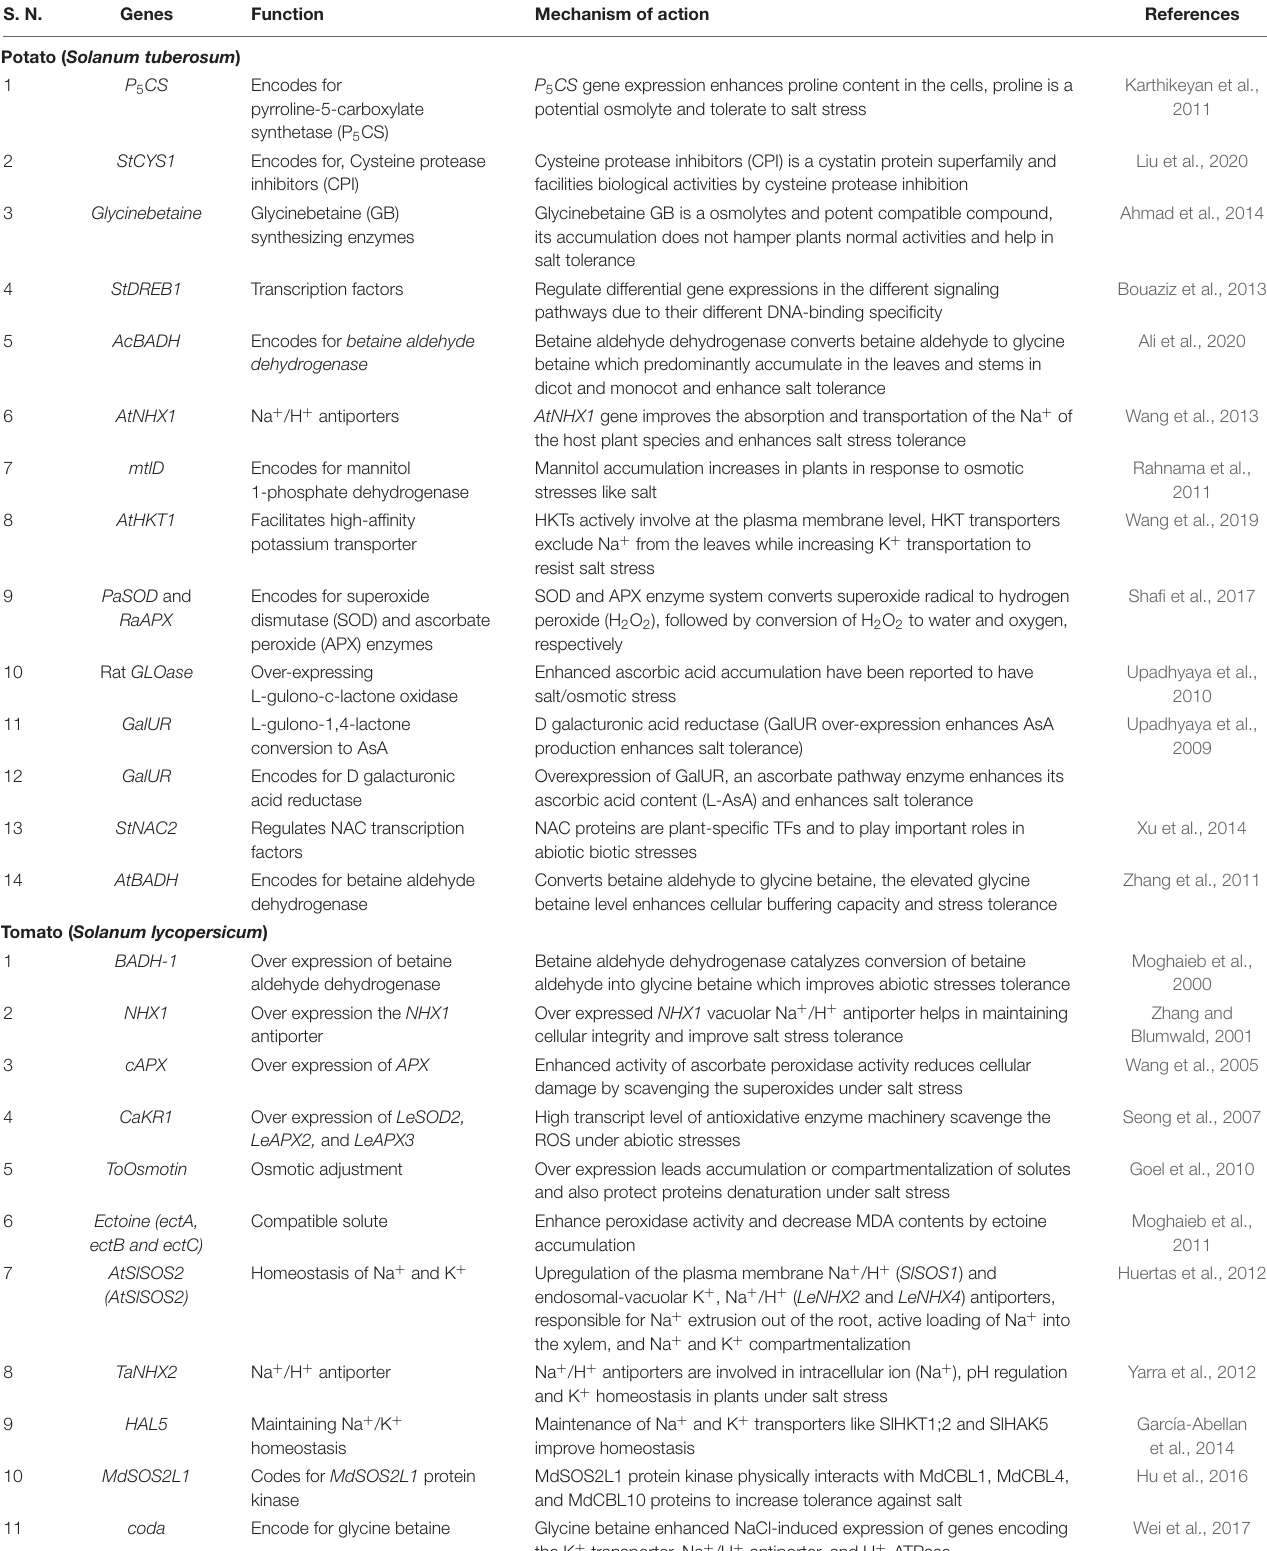
TABLE 1 | Transgene used for development of salt stress tolerance, their function and mechanism of action. S.